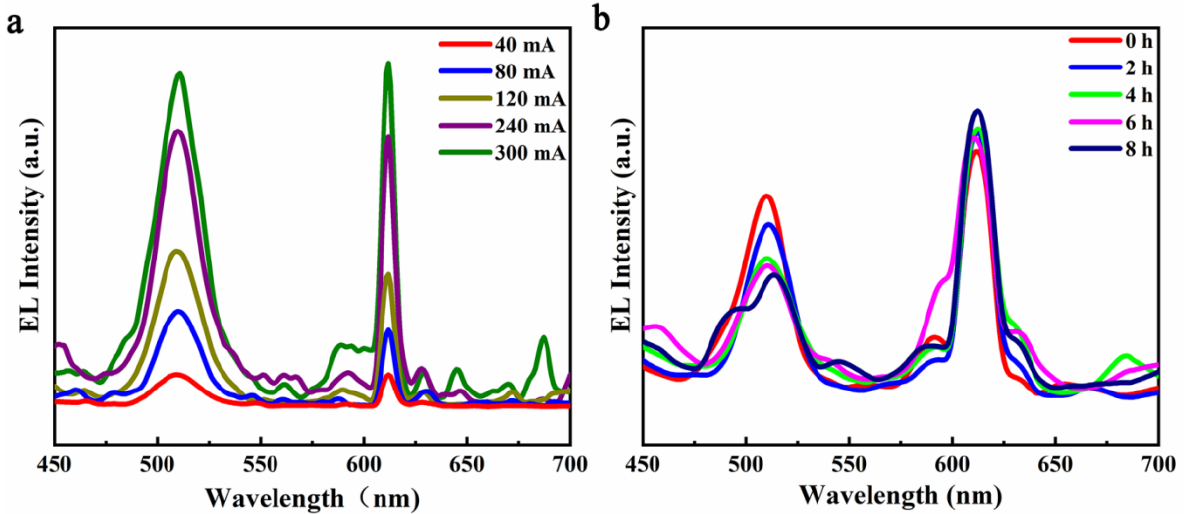
Figure 2. ( a ) EL curves of the W-LED under different current currents; ( b ) the EL curve of W-LED varied with time.